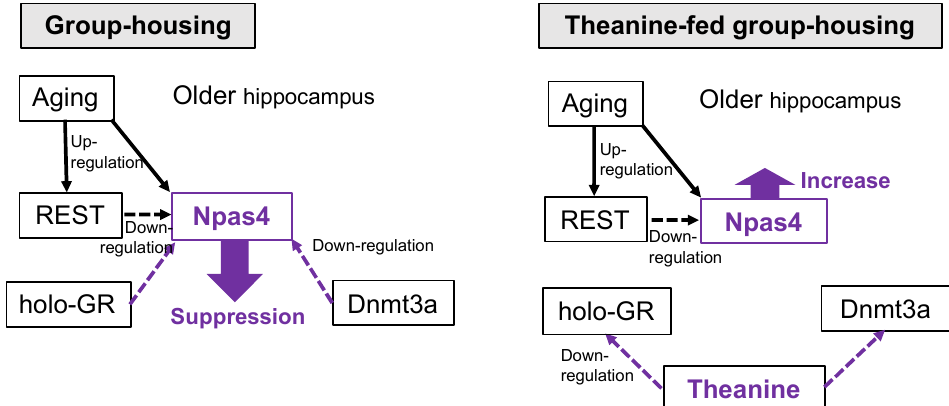
Figure 9. Factors relating to changes in Npas4 expression due to stress and aging, and the role of theanine. Solid line: upregulation. Dashed line: downregulation.